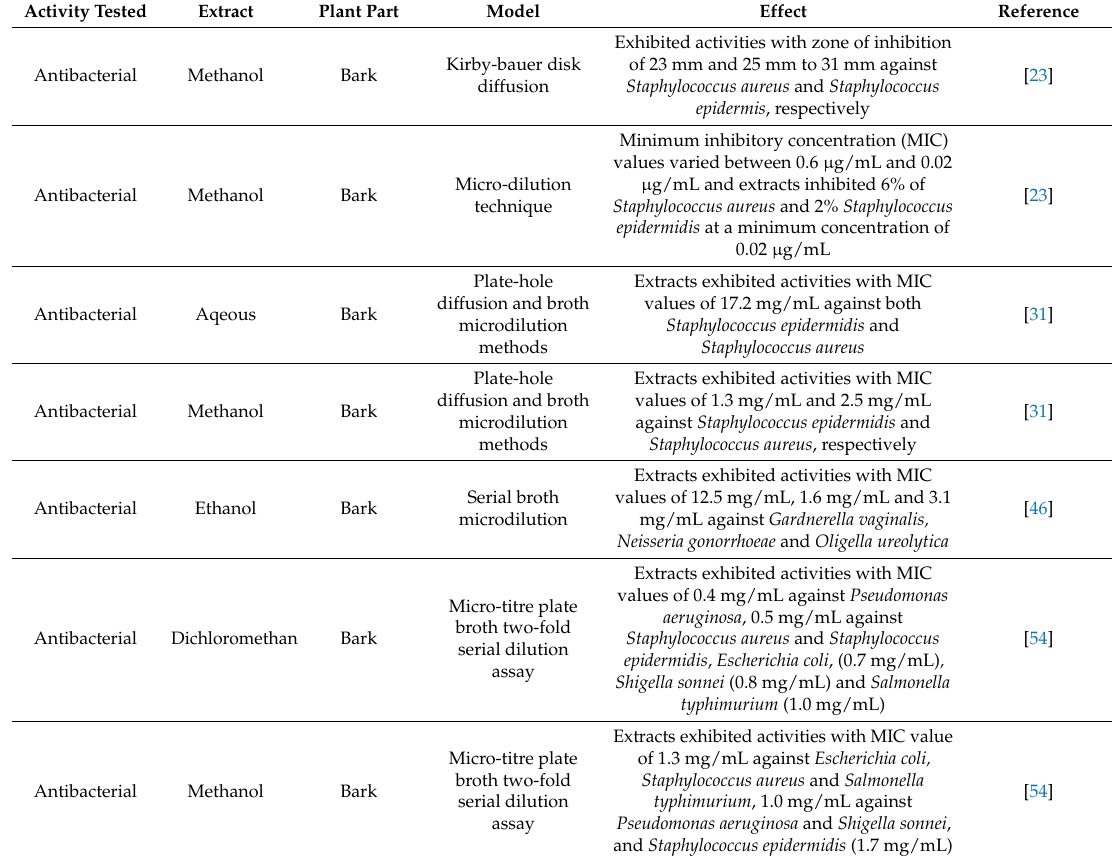
Table 4. Summary of pharmacological activities of Elaeodendron transvaalense crude